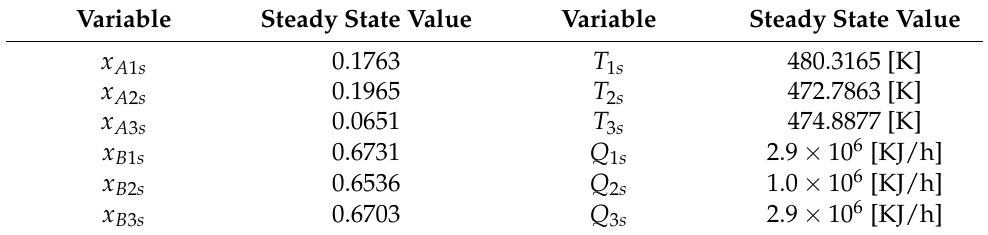
Table 1. Steady state